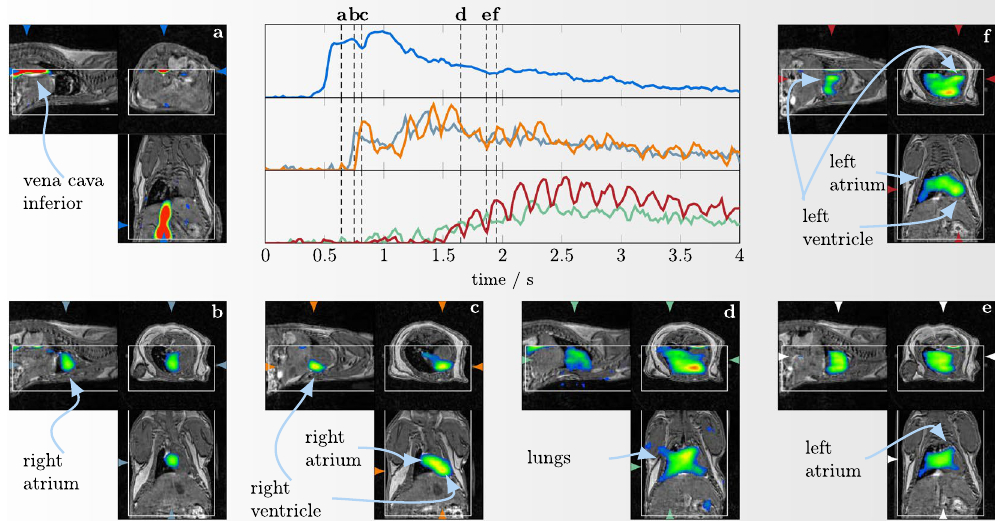
Figure 9. 4D in vivo reconstruction results of the bolus experiment with the highest concentration (51.2 μ g/10 μ L) at a time resolution of 21.41 ms. Shown are selected image fusions that reveal how the bolus passes through the mouse heart. The white box inside the images indicate the MPI FOV. Additionally, at the center the temporal progression of the signal in different selected structures (vena cava (top), right atrium and right ventricle (middle), left atrium and left ventricle (bottom)) are shown. See Supplementary video S3 for an animated version of this